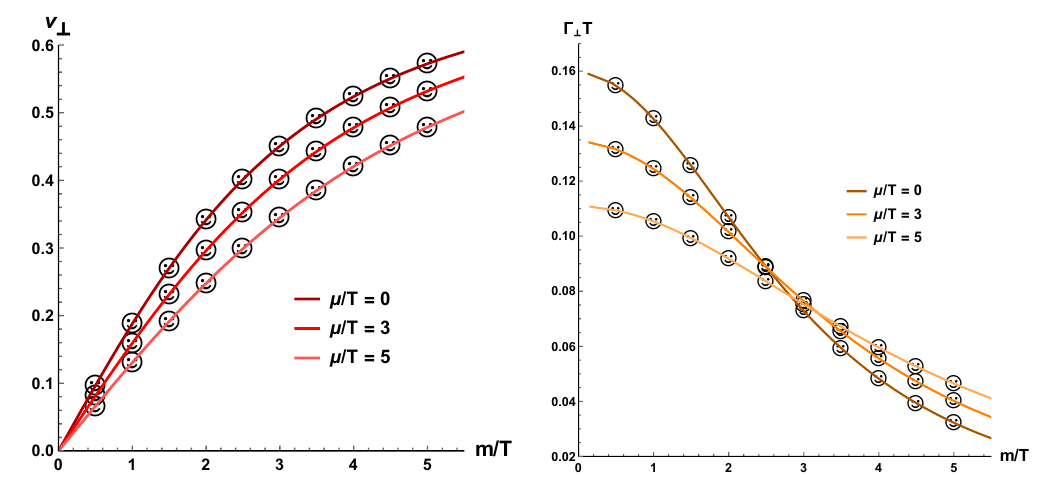
Figure 6 . The predictions from hydrodynamics for the benchmark potential V ( X ) = m 2 X 3 and various values of (cid:22)=T . Left: The speed of transverse sound. The smileys indicate the numerical values obtained by (cid:12)tting the real part of the quasinormal modes Re[ ! ] = v ? k . Right: The transverse sound attenuation constant. The smileys indicate the numerical values obtained by (cid:12)tting the real part of the quasinormal modes Im[ ! ] = (cid:0) 1 (cid:0) ? k 2 . 2